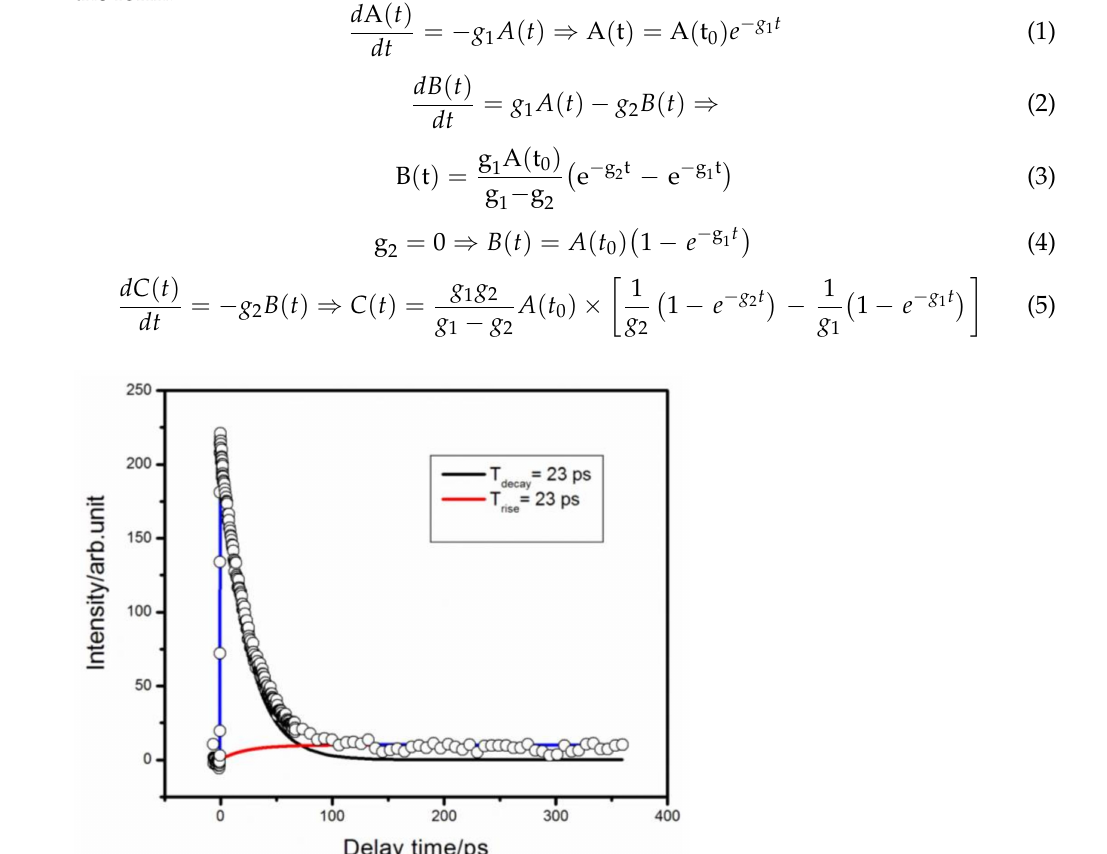
Figure 1. Time decay of the parent ion obtained with 260 nm pump and 400 nm probe detection. The circles are experimental results, and the solid lines are fits to a convolution of a Gaussian cross- correlation function and exponentially decaying and exponentially rising functions. This resulted in different time